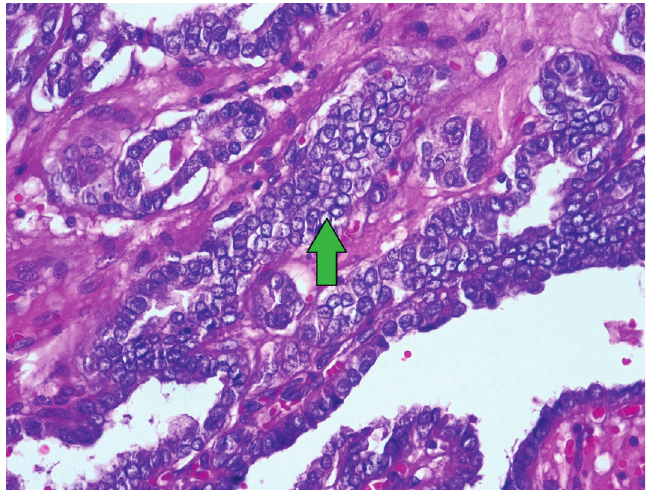
Figure 1 B - The nuclear clarification (green arrow) in the papillary